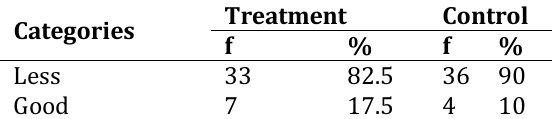
Table 3. Description of Knowledge Level of Respondents about Leptospirosis before Being Given Health